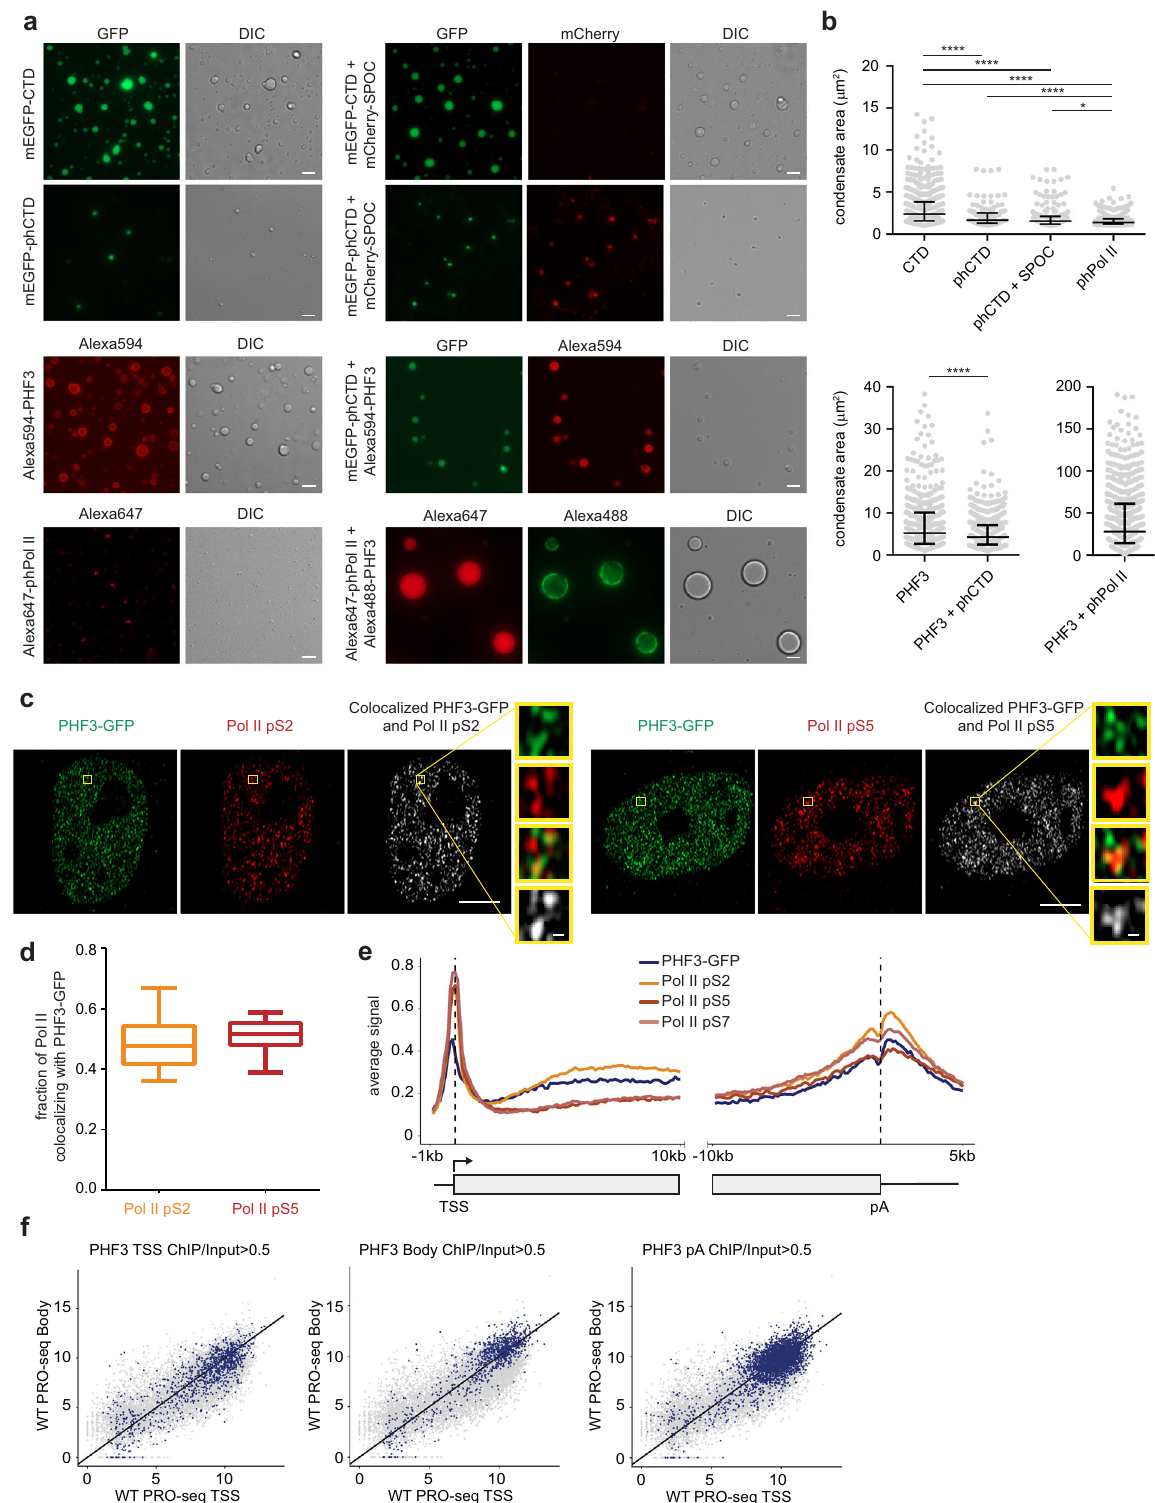
newly synthesized RNA. Super-resolution imaging revealed reduced signal in Pol II clusters that overlap with PHF3 (Fig. 4a, b), indicating that PHF3 may be associated with reduced transcriptional activity. To further elucidate the function of PHF3 in transcription, we used CRISPR/Cas9 to generate PHF3 knock-out HEK293T cells (PHF3 KO) and HEK293T cells lacking the SPOC domain (PHF3 Δ SPOC) (Supplementary Fig. 7). PHF3 Δ SPOC was expressed at lower levels